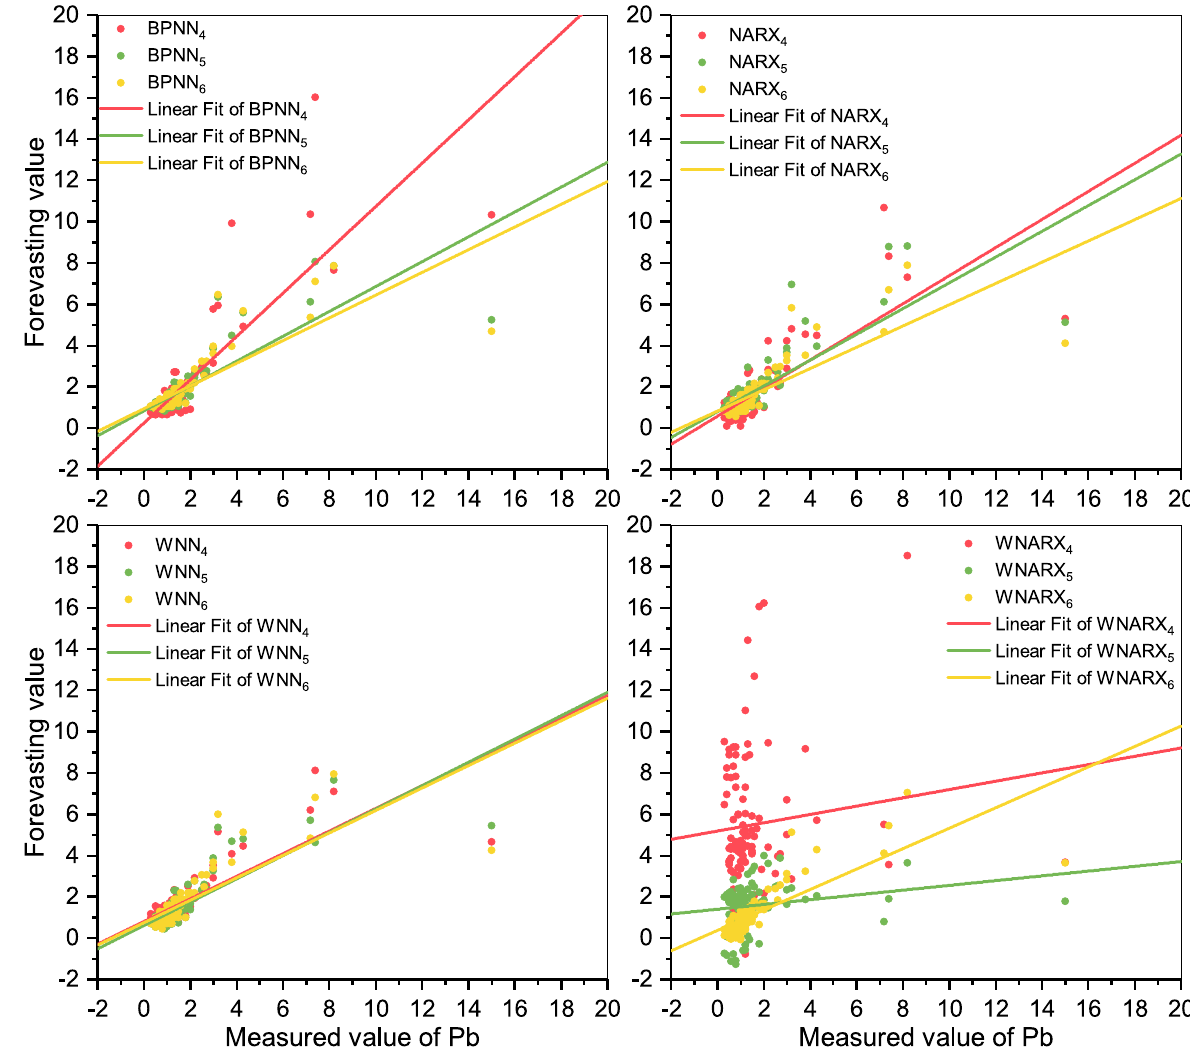
Figure 7. Scatter plots of Pb. The figure shows the scatters distributions under different scenarios for Pb and the linear fit of different scenarios. Meanwhile, the color choice keeps the same as Fig.